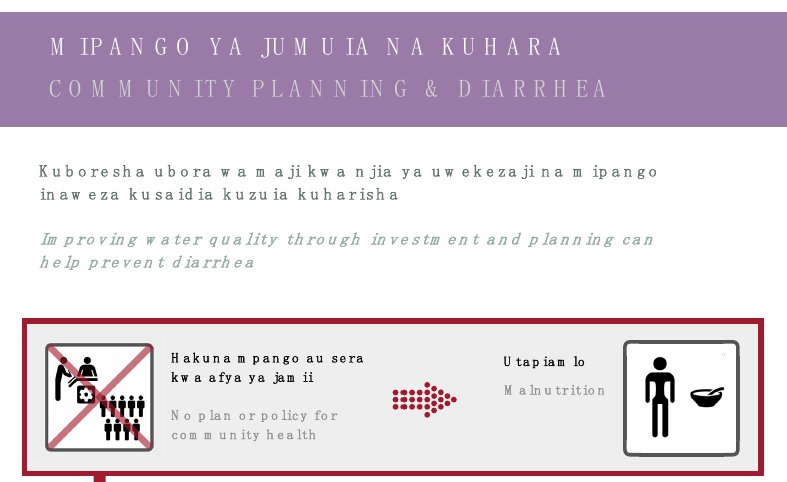
Figure 7. Community Graphic Used for Planning Climate Justice in Mukuru.